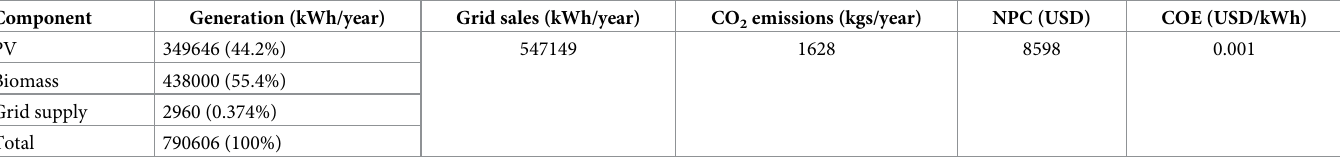
Table 8. Simulation results for